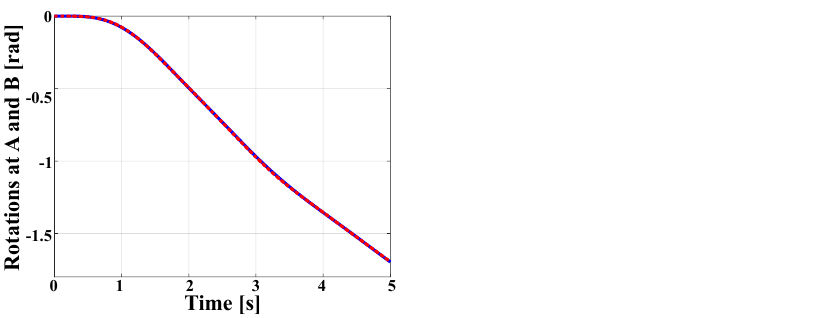
Figure 11. Rotations for the revolute joints at points A (solid line) and B (dashed line).